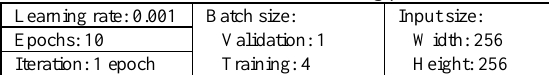
Table 1. Neural network training